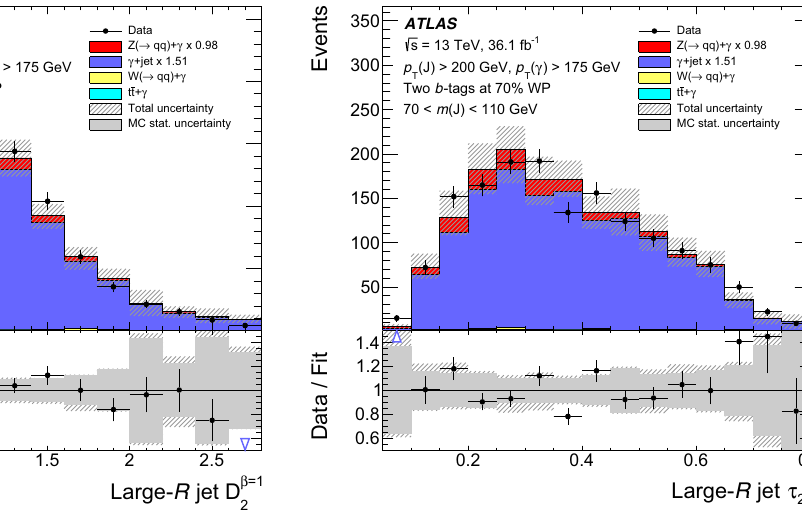
Fig. 19 Z → b ¯ b candidate jet mass after applying the τ 21 < 0 . 45 (left) or D are used. The γ + jets background and the Z → b ¯ b signal are normalised to data by applying a scale factor of 1 . 51 and 0 . 98, respectively